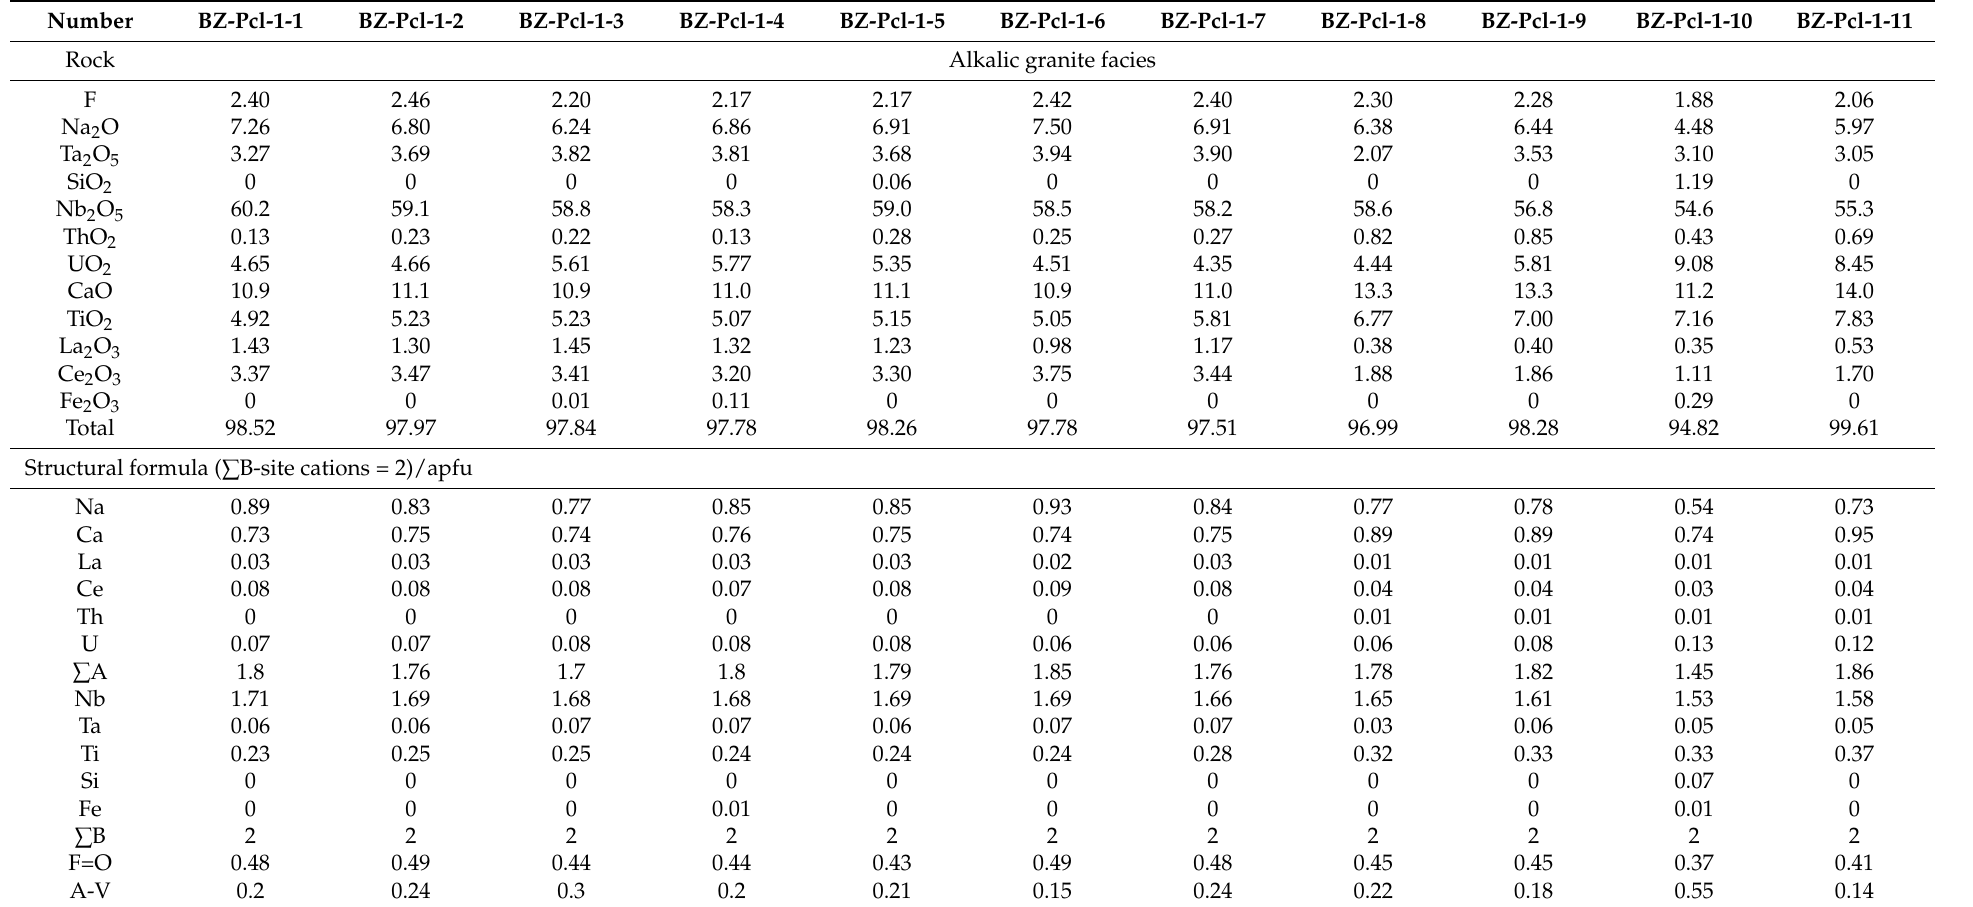
Table 1. Chemical composition of pyrochlore group minerals from the Boziguoer Nb